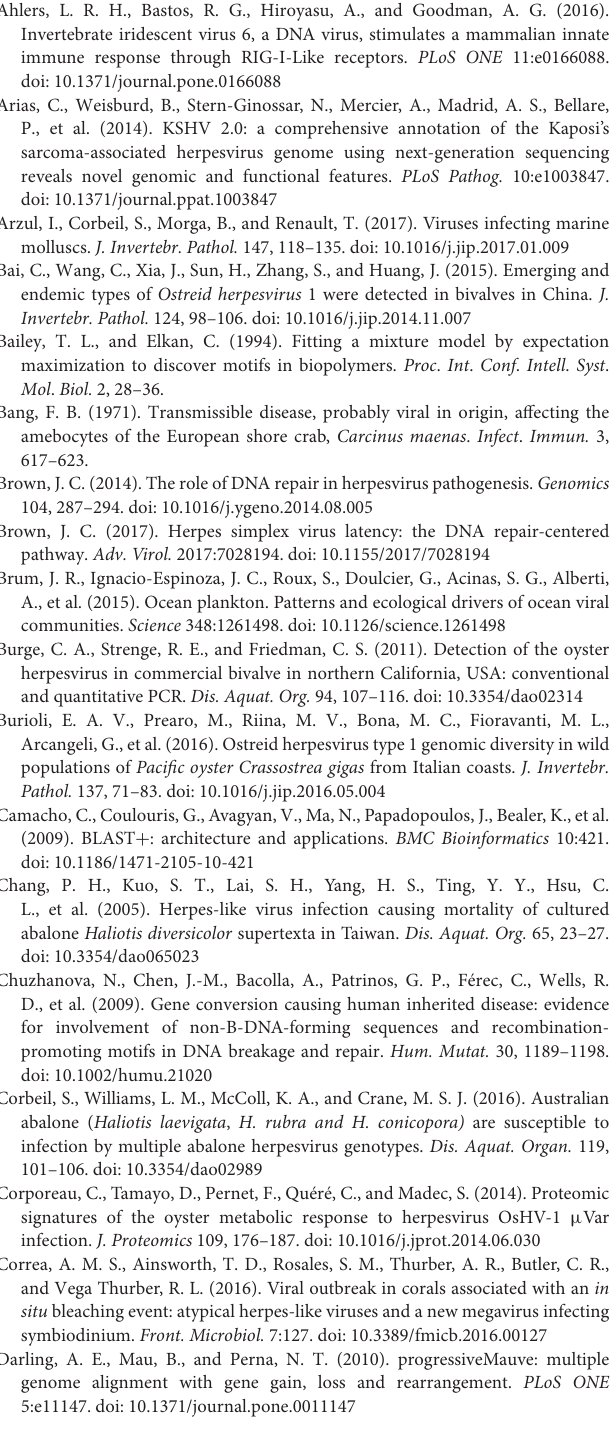
Supplementary File 6 | ORF expression analysis. Figure SF6_1. Correlation plot of Principal Component Analysis (PCA). Red and green dots indicate RNA-seq samples labeled as “high” or not labelled, respectively. Figure SF6_2. Clustering of